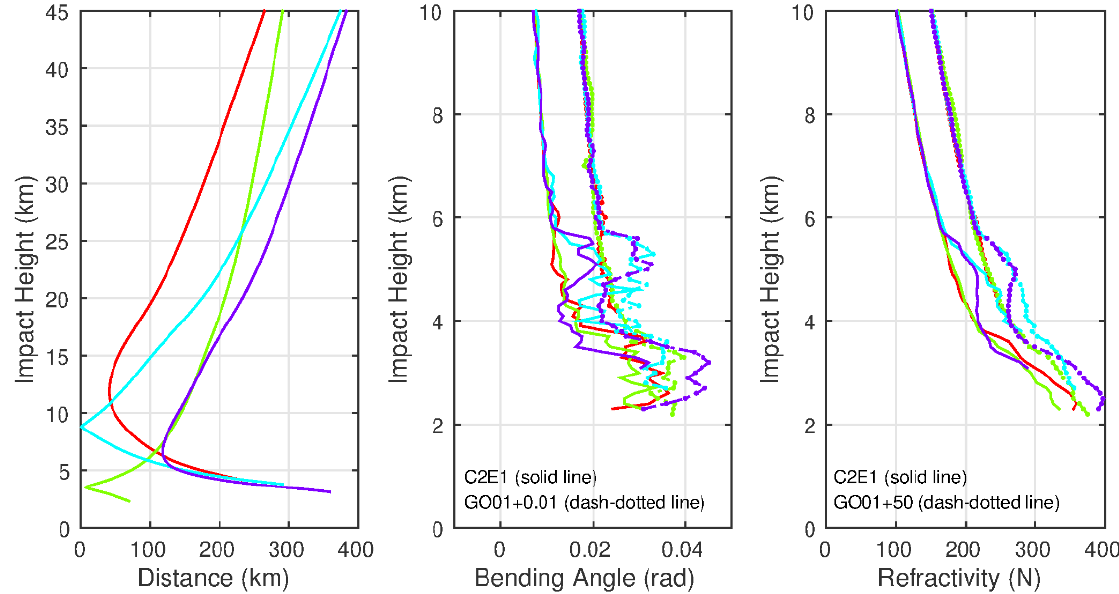
Figure 12. Four SRO events between COSMIC-2-FM1 (C2E1) and GeoOptics-01 (GO01) during the comparison period: ( left ) the horizontal differences with impact height, ( middle ) bending angle profiles (solid lines for C2E1, and dash-dot lines for GO01 by shifting a fixed amount of 0.01 radian), and ( right ) refractivity profiles (the GO01 profiles are shifting a fixed amount of 50 N).